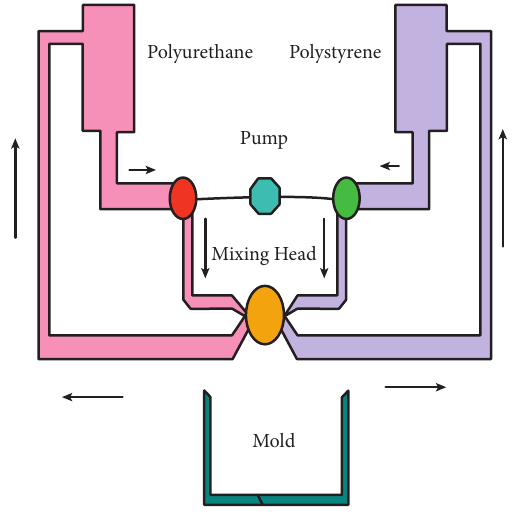
Figure 2: Basic process of reaction injection molding. Table 1: Assumption for the automobile instrument based on four configurations includes filling period, temperature, power, and stripe characteristics Filling period Flow front temperature Clamping power Welding stripe characteristics The length is large and a greater number of pieces